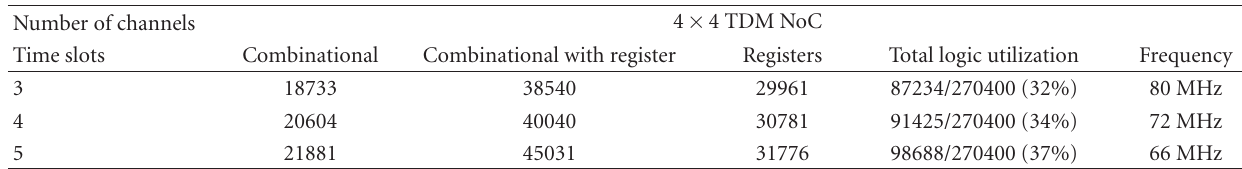
Table 9: Synthesis results 4 × 4 TDM-based